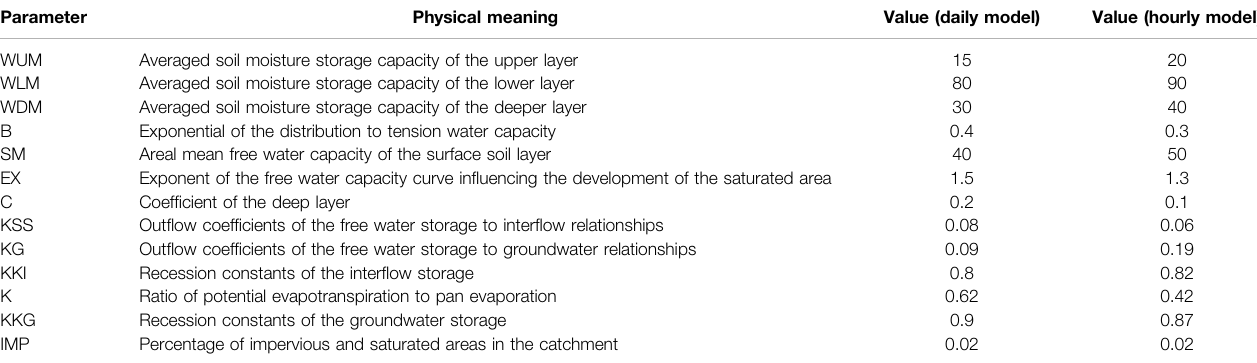
TABLE 2 | The parameters of XAJ model.